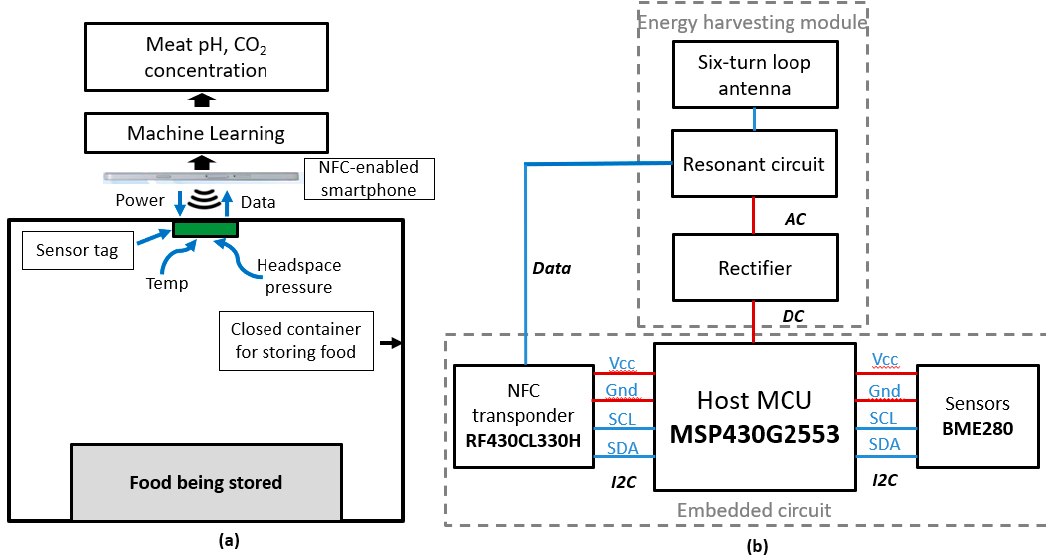
Figure 1. Proposed prototype system: ( a ) block diagram of the proposed system; ( b ) block diagram of the designed sensor tag.